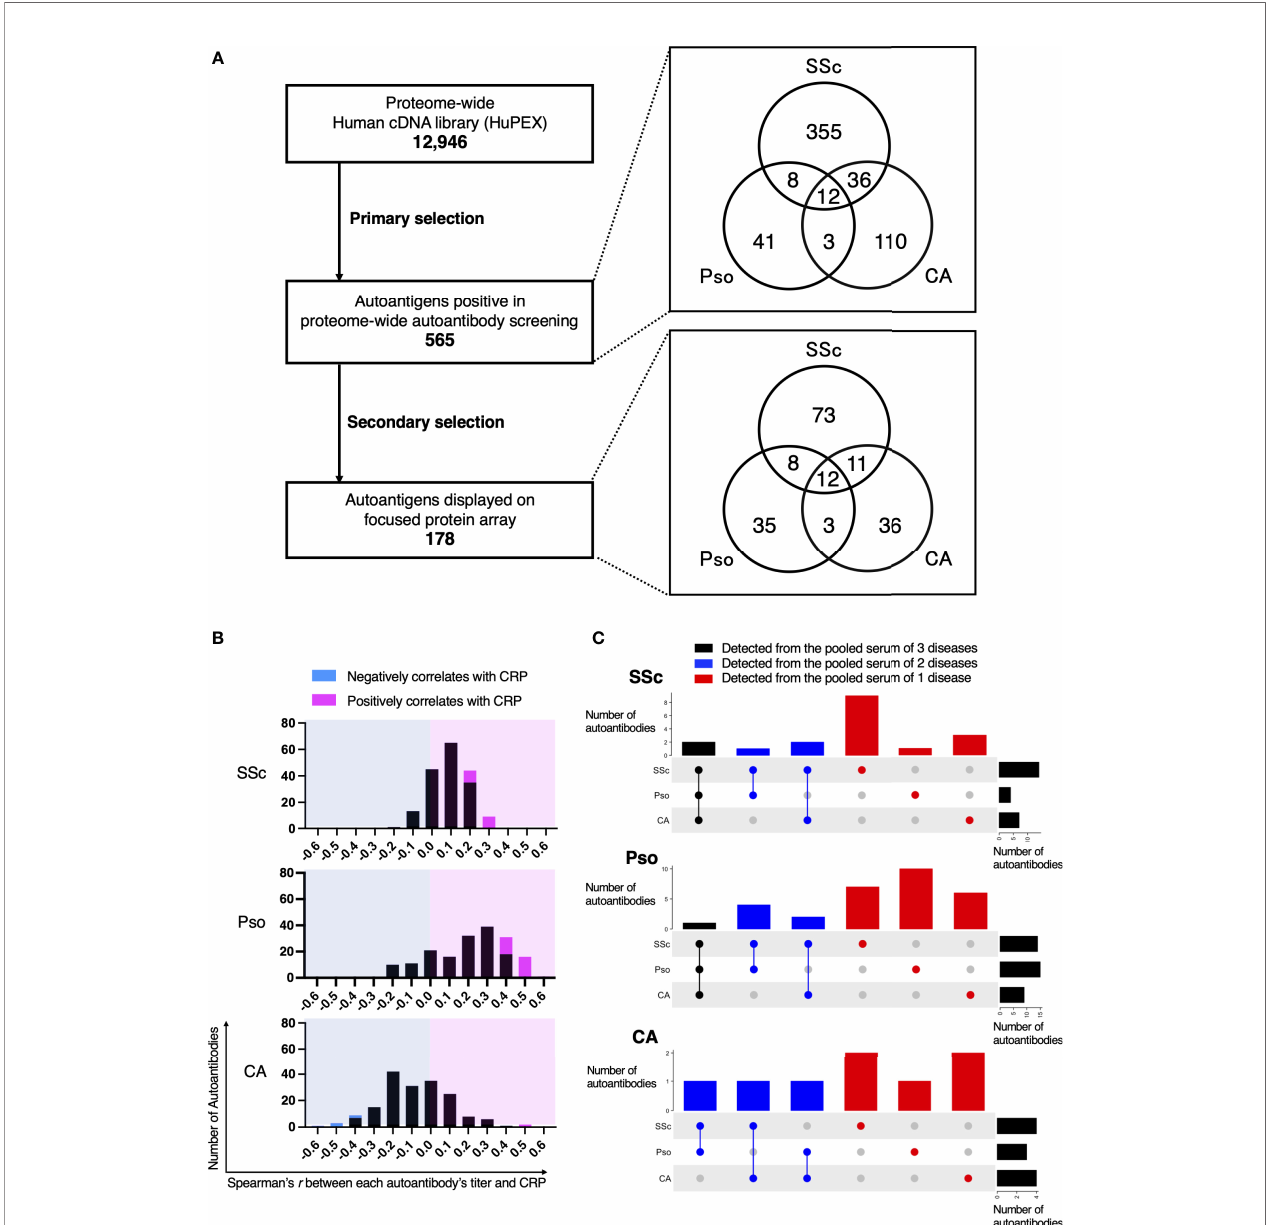
FIGURE 2 | Intra- and Inter-diversity of correlation between serum levels of C-reactive protein and autoantibody level. (A) Flow-chart of autoantibody selection. The number of entry cDNA clones was 12,946. As primary selection, proteome-wide autoantibody screening from pooled serum of patients with systemic sclerosis (SSc), psoriasis (Pso), or cutaneous arteritis (CA) detected 565 positivity. Their origin in primary screening is illustrated in a Venn diagram. As secondary selection, a search for association between the diseases by PubMed and for subcellular localization by the Cell Atlas was conducted. Finally, 178 proteins were spotted on the focused protein array. Their origin in primary screening is also shown in a Venn diagram. (B) Histograms of Spearman ’ s correlation coef fi cient between serum CRP and each autoantibody level in individual sera of patients with SSc, Pso, and CA. Autoantibodies that negatively or positively correlated with serum CRP with statistical signi fi cance are highlighted in cyan or in magenta, respectively. (C) UpSet plots that visualize the origin of autoantibodies in primary screening that signi fi cantly correlates with serum